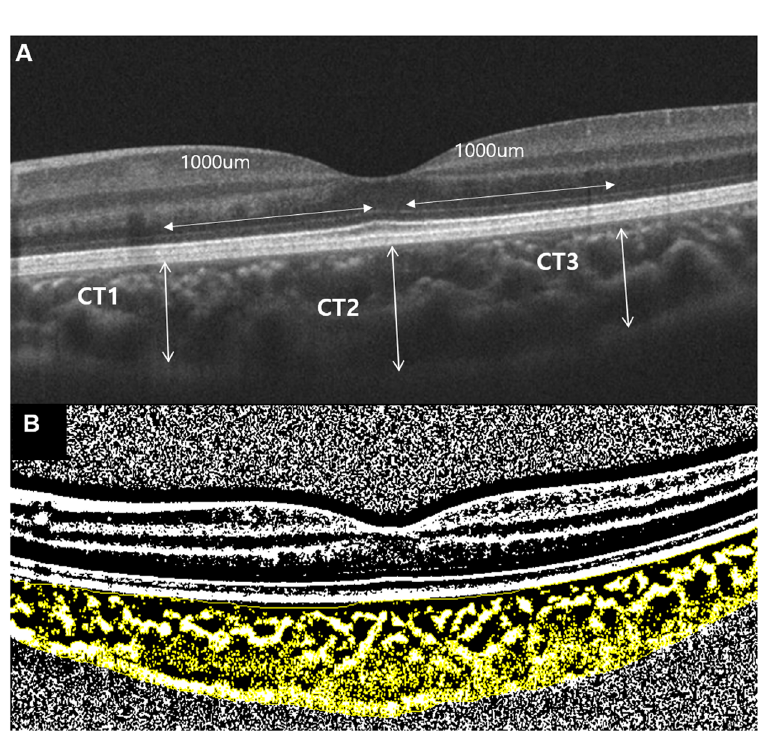
Figure 4. Measurements of choroidal thickness and vascularity. ( A ) Nasal parafoveal choroidal thickness (CT1), subfoveal choroidal thickness (CT2), and temporal parafoveal choroidal thickness (CT3) were obtained using enhanced depth image optical coherence tomography. CT was measured as the distance between Bruch’s membrane and the choroid-scleral interface. ( B ) The subfoveal choroidal area with a width of 3 mm, centered at the fovea, was selected. Using ImageJ software, the image was binarized with Niblack’s method, and the ratio of vascular area (black pixels) to stromal area (white pixels) was